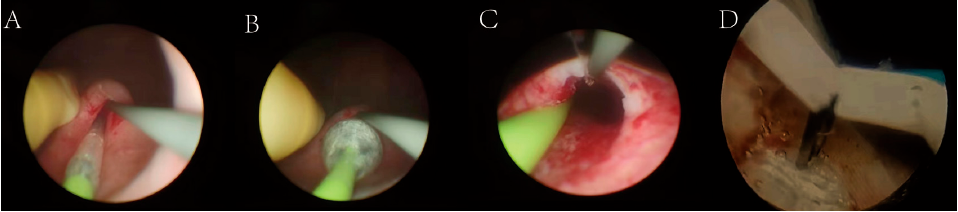
Figure 2. Balloon dilation and endoureterotomy. ( A ) Placement of a balloon in the stenotic segment. ( B ) The balloon is filled with water and left for 3–5 min. ( C ) The dilated ureteral stenosis was wider than before. ( D ) Cutting of stenotic segments.